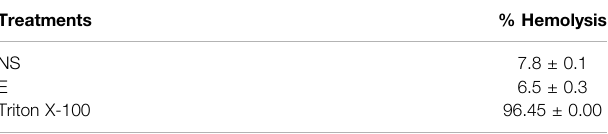
TABLE 4 | Hemolytic activity of N. sativa extract and